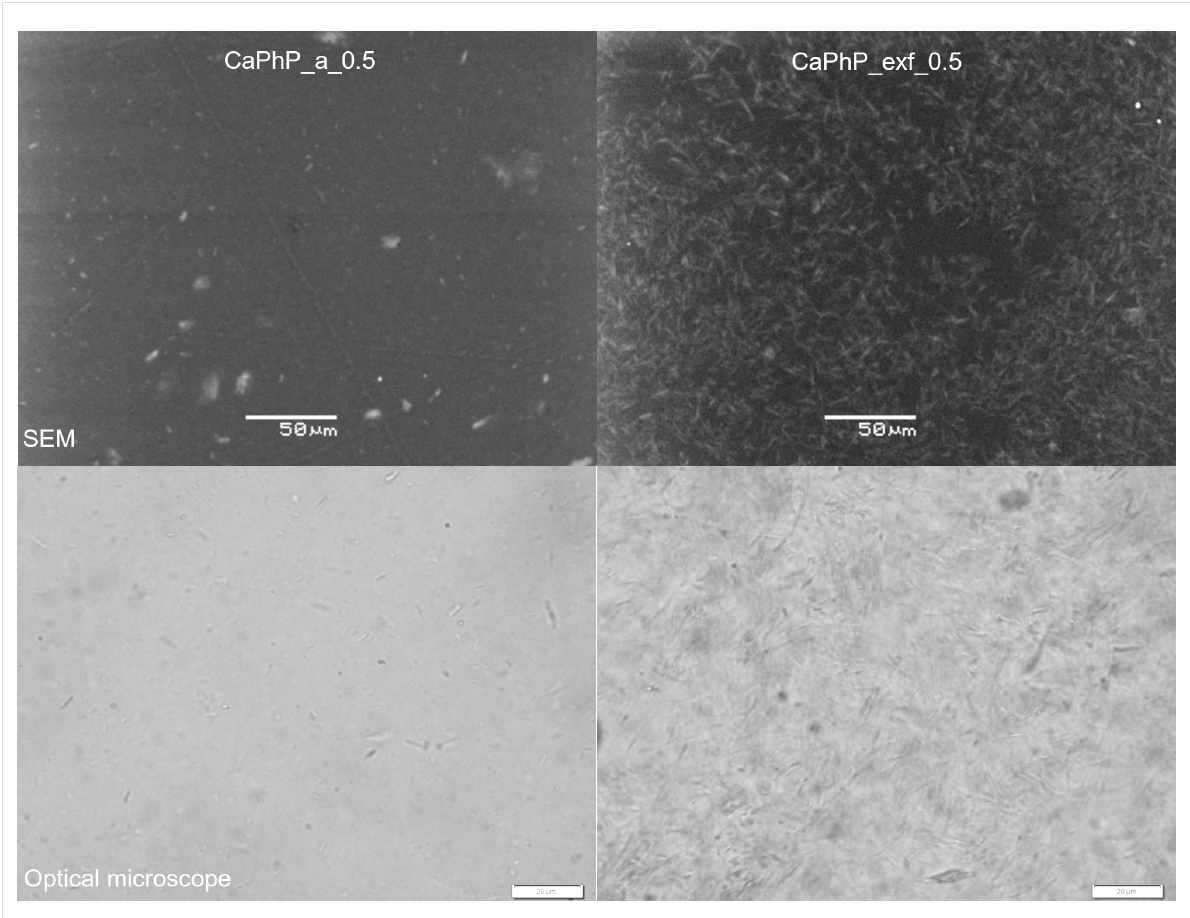
Figure 7: Pictures of the composite-free films with 0.5 wt % loading of the filler obtained from the scanning electron microscope and from the optical microscope. Scale bars in the optical microscope pictures are 20 µm.